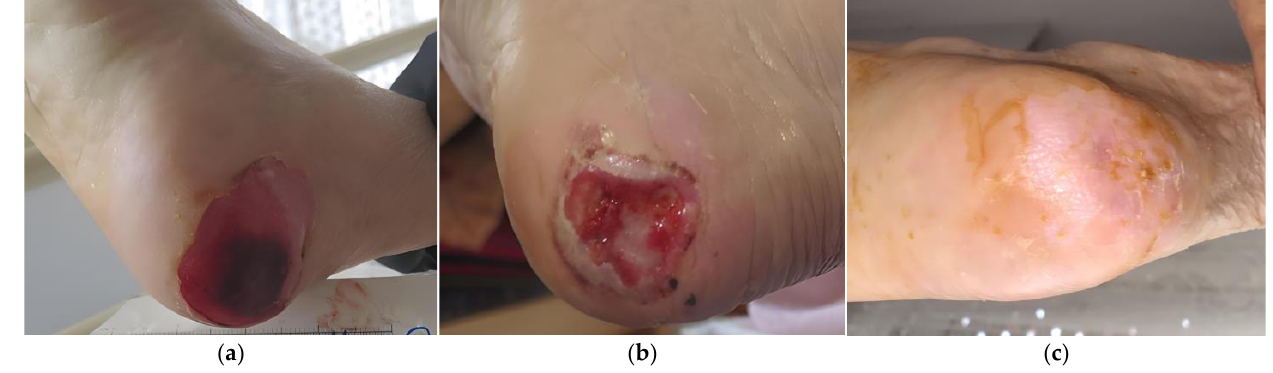
Figure 5. Case 5: ( a ) clinical findings at the initial examination, day 0 (start of MGH treatment); ( b ) resolution of local infection and improved wound healing after two weeks of MGH therapy; ( c ) complete wound healing after 31 weeks of MGH therapy.